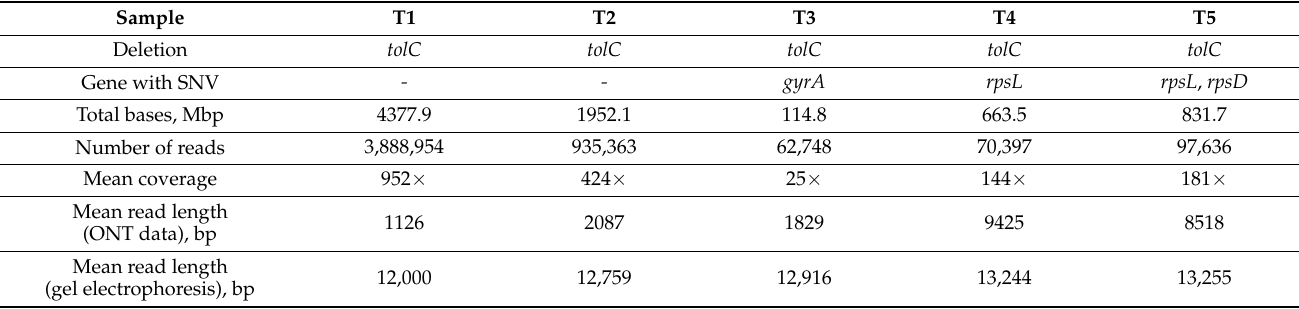
Table 1. Main features of the considered samples. Deletions and SNVs are confirmed by alternative experimental